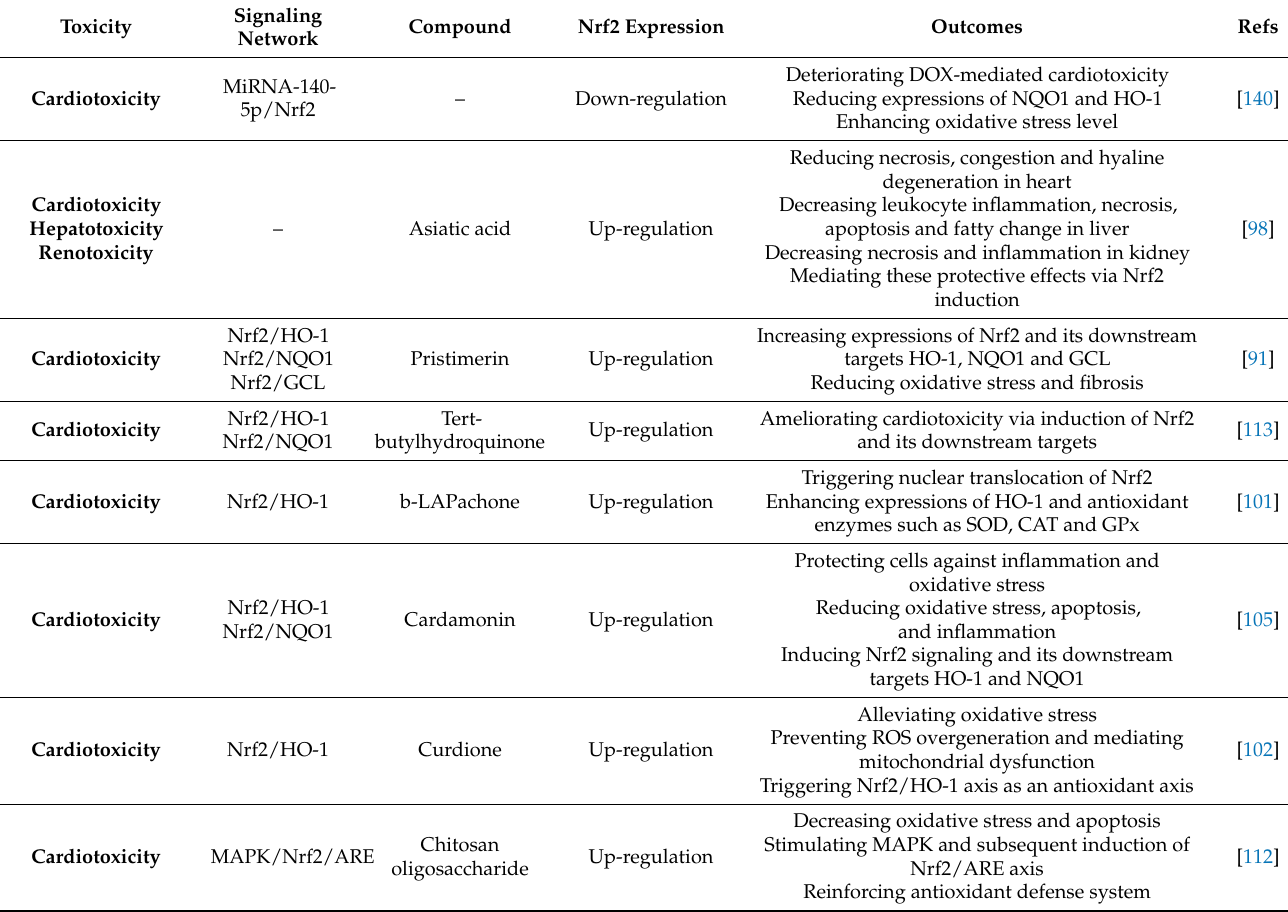
Table 1. Nrf2 signaling as a chemoprotection